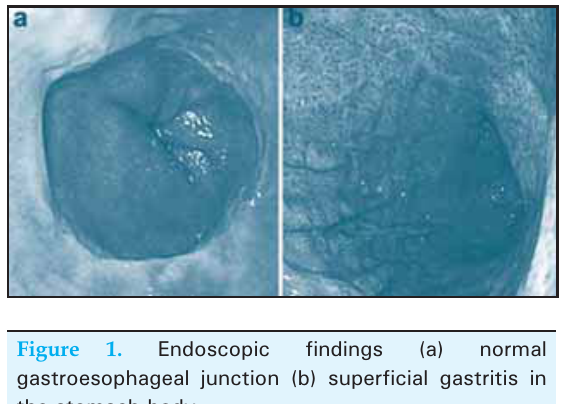
Figure 1. Endoscopic (cid:3) ndings (a) normal gastroesophageal junction (b) super(cid:3) cial gastritis in the stomach body He developed symptoms of progressive dysphagia, heart burn and regurgitation two weeks after completion of H. pylori eradication. There was no history of any other medications after H. pylori eradication and before the appearance of his symptoms. Follow-up endoscopy along with a CLO test was repeated due to the symptoms, but the CLO test was negative for H. pylori.